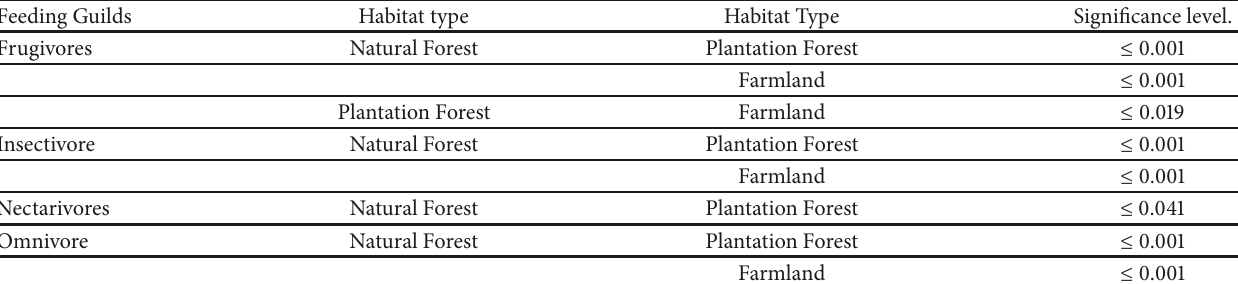
Table 2: Tukey’s HDS test significant